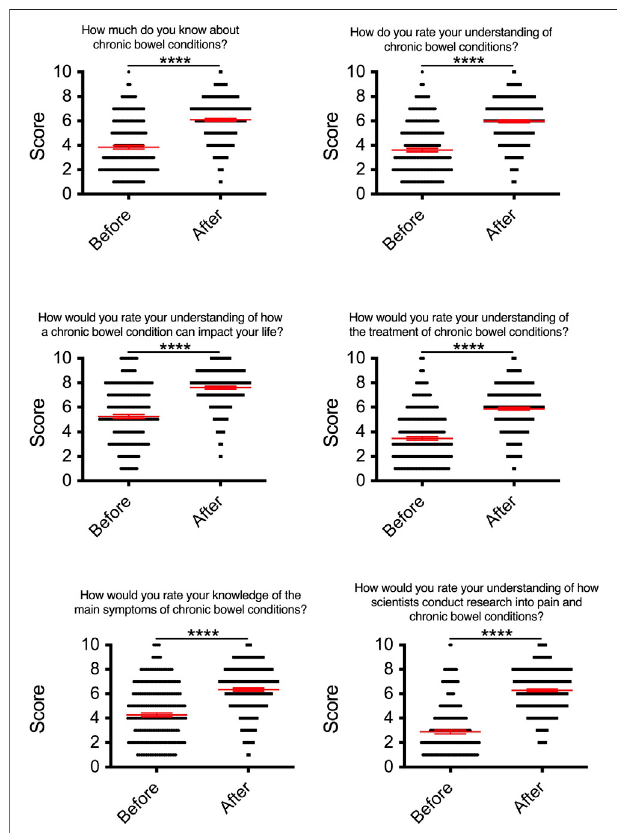
FIGURE 3 | Participant responses to the following identical questions before vs. after viewing “ Gut Reaction ” .